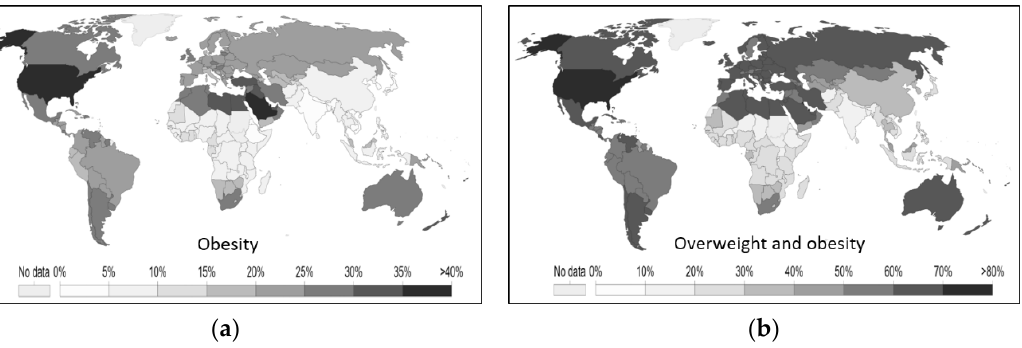
Figure 11. ( a ) Percentages of obese adults in various countries. ( b ) Percentages of overweight adults by country [37].